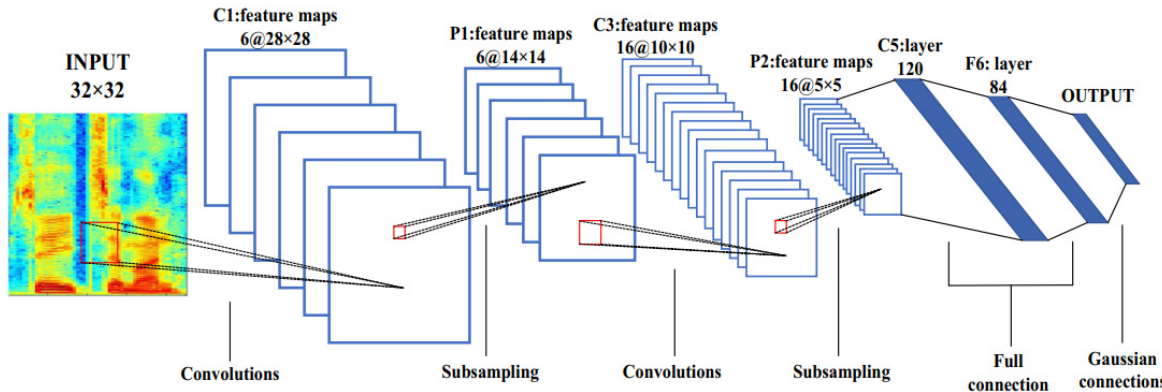
Figure 1. Architecture of a typical CNN.